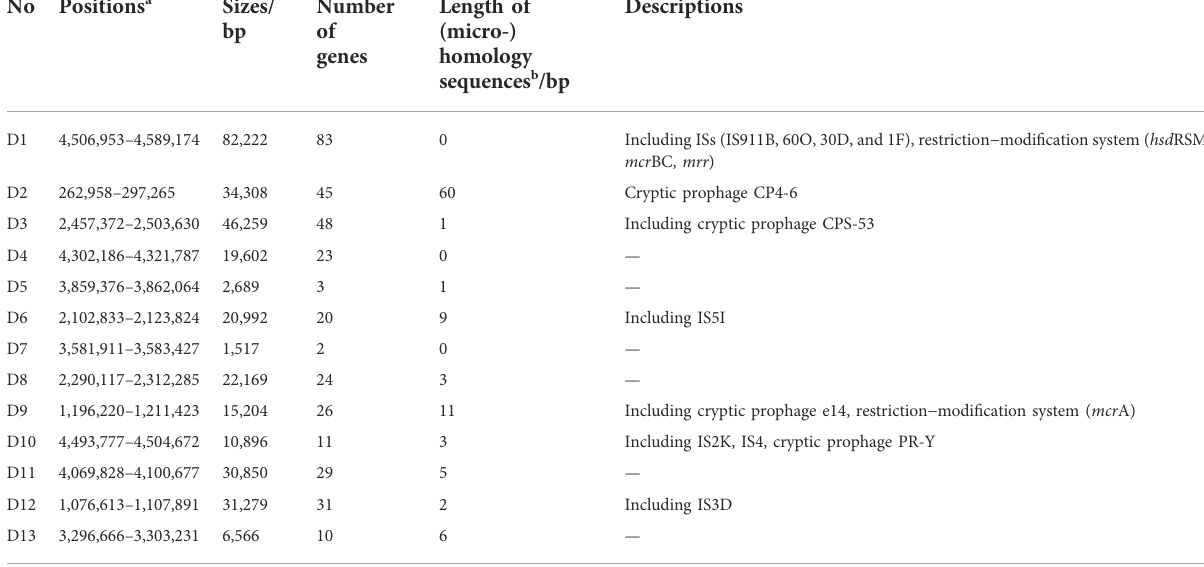
TABLE 3 Details of the deletion events in the fi ve selective